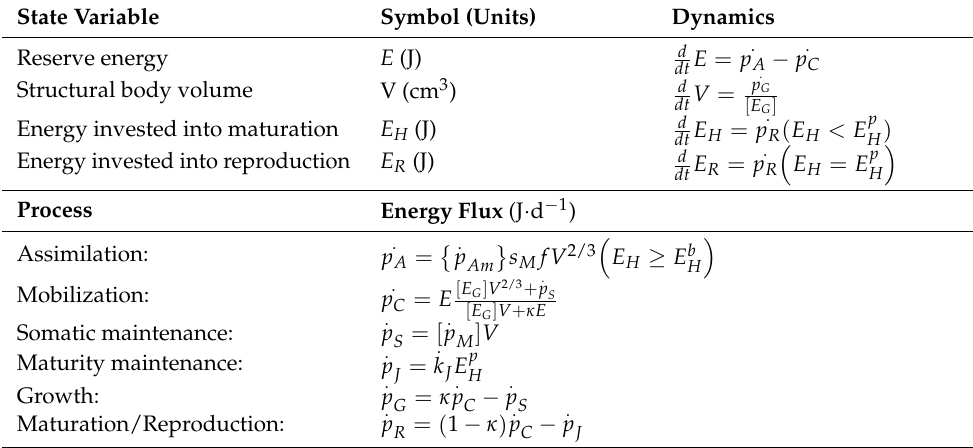
Table A1. State variables and main processes of the Dynamic Energy Budget (DEB) abj-model, which includes a change in parameter values between birth and